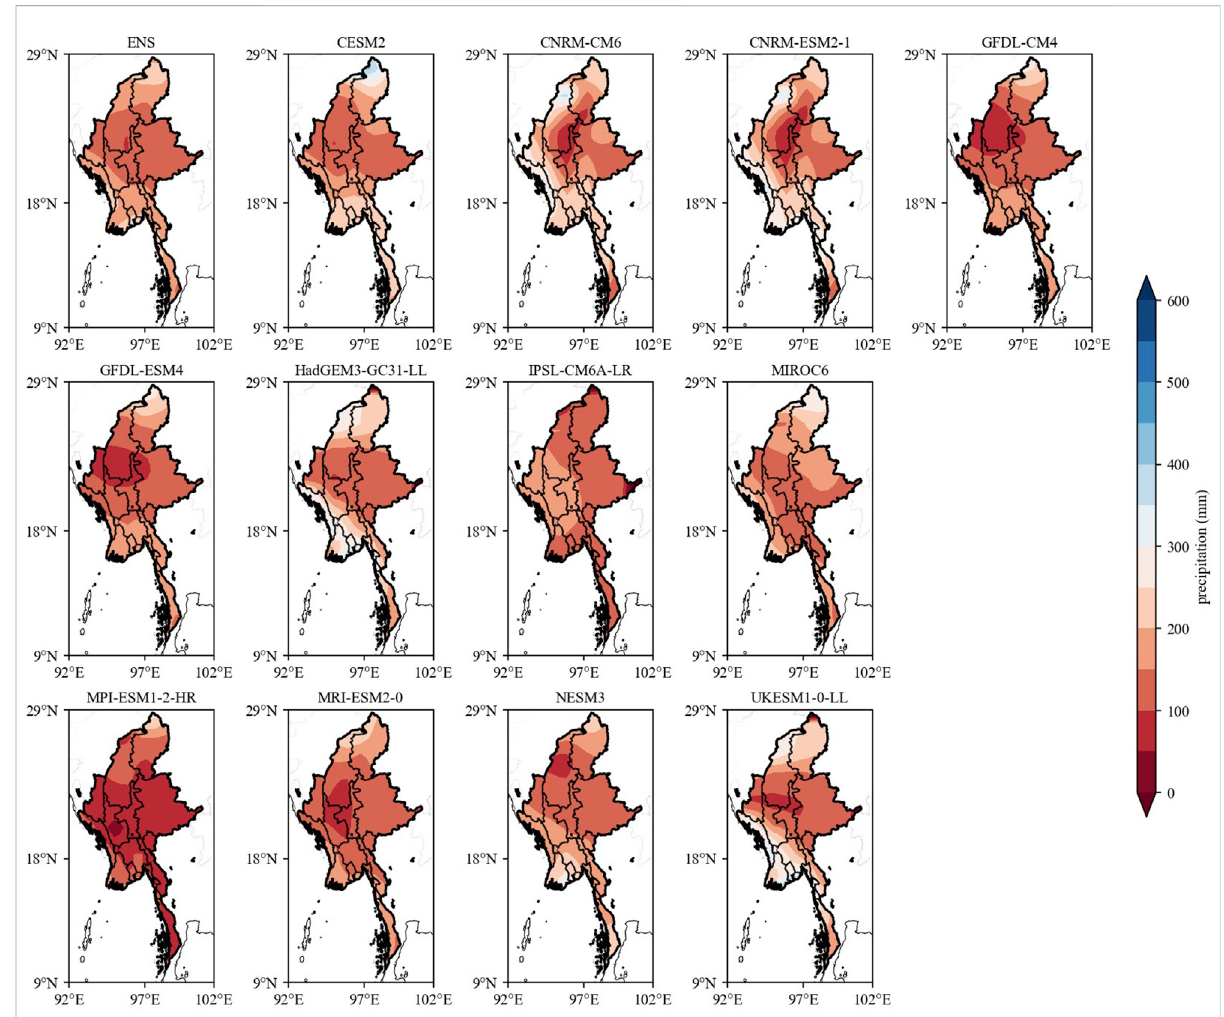
FIGURE 4 Spatial distribution of annual mean precipitation for the selected 12 CMIP6 models as well as their ensemble mean during 1970 – 2014